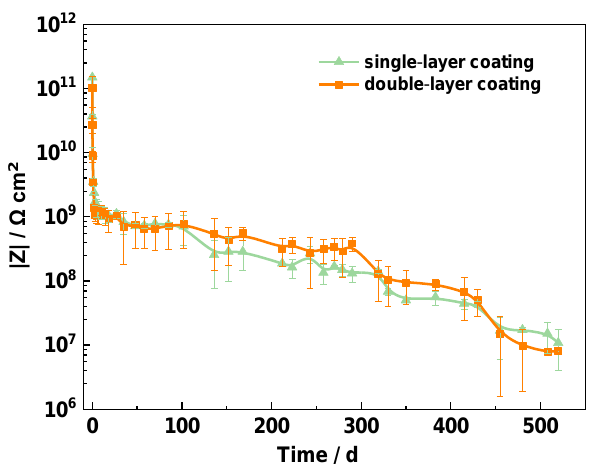
Figure 8. |Z| 0.01 Hz variations of single-layer and double-layer coating samples with immersion time.